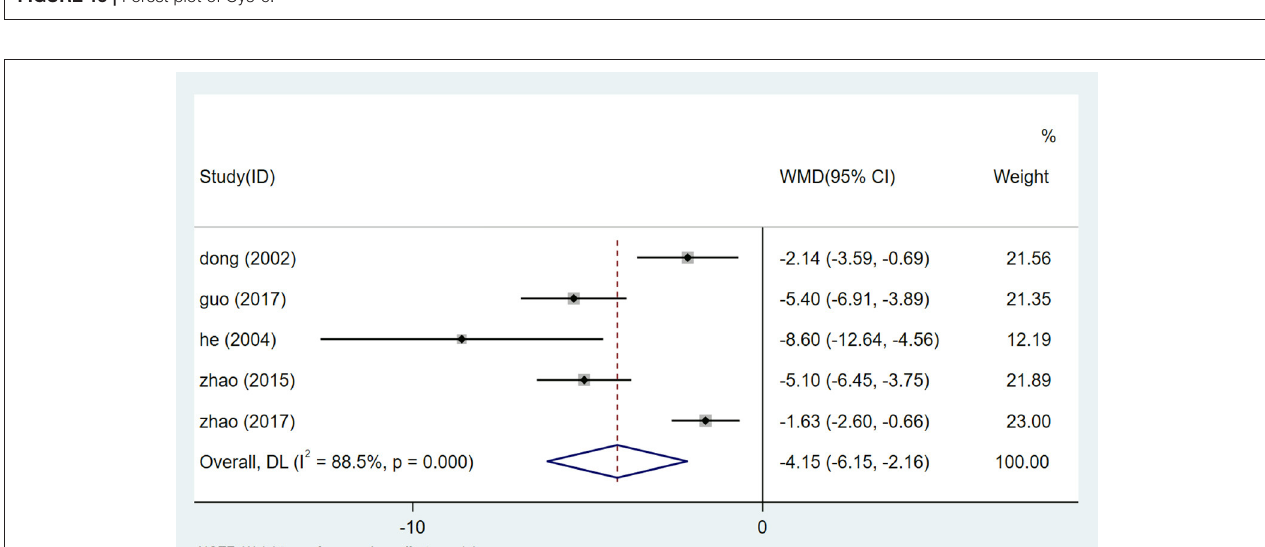
FIGURE 14 | Forest plot of